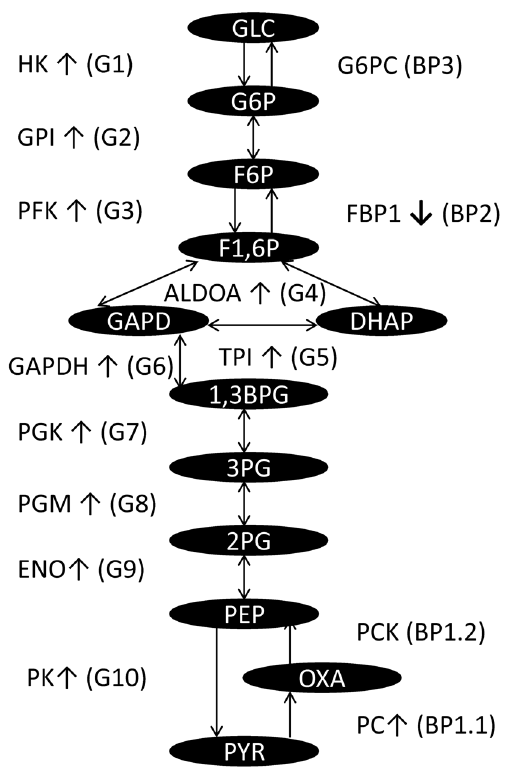
Figure 2. Gene expression regulation analysis of glycolysis and gluconeogenesis in NSCLC. The Figure shows the pathways of cellular glycolysis and gluconeogenesis. Oval shape text represents the metabolites of the pathways. GLC=Glucose, G6P=Glucose-6-phos- phate, F6P=Fructose 6-phosphate, F1,6P=Fructose 1,6-bisphosphate, GAPD=Glyceraldehyde 3-phosphate, DHAP=Dihydroxyacetone phos- phate, 1,3-BPG=1,3-Bisphosphoglyceric acid, 3PG=Glycerate 3-phos- phate, 2PG=Glycerate 2-phosphate, PEP=Phosphoenolpyruvic acid, PYR=Pyruvic acid, OXA=Oxaloacetate. Gene symbols, regulation state ( q or Q if detected) and pathway (in the parentheses, G1-10: glycolysis step 1–10, BP1-3: gluconeogenesis bypass step 1–3) are indicated.